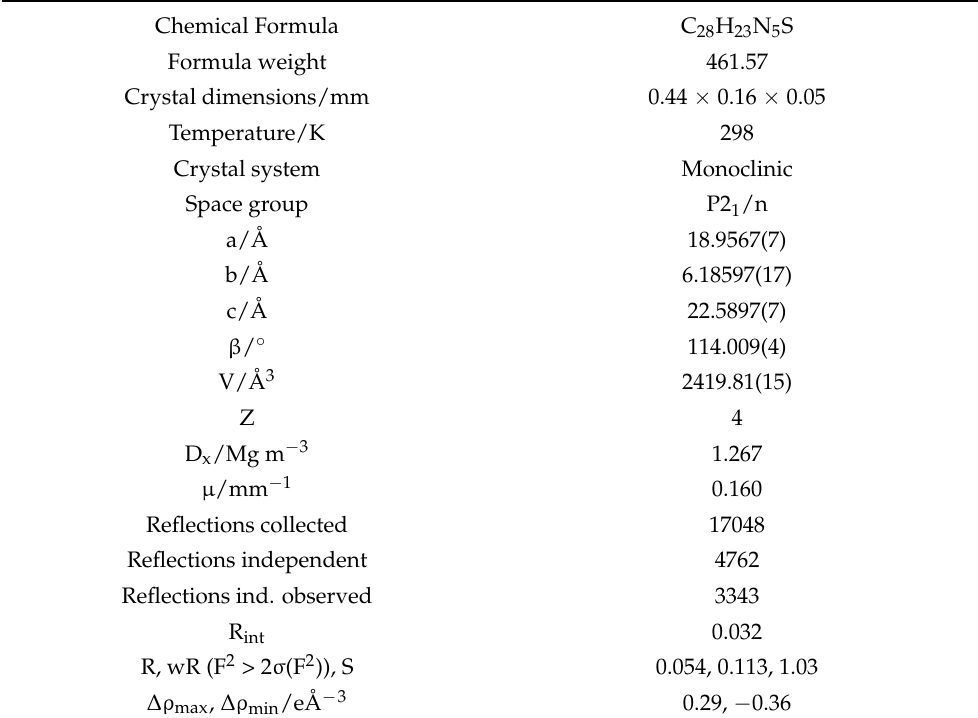
Table 2. Selected crystallographic and experimental data for